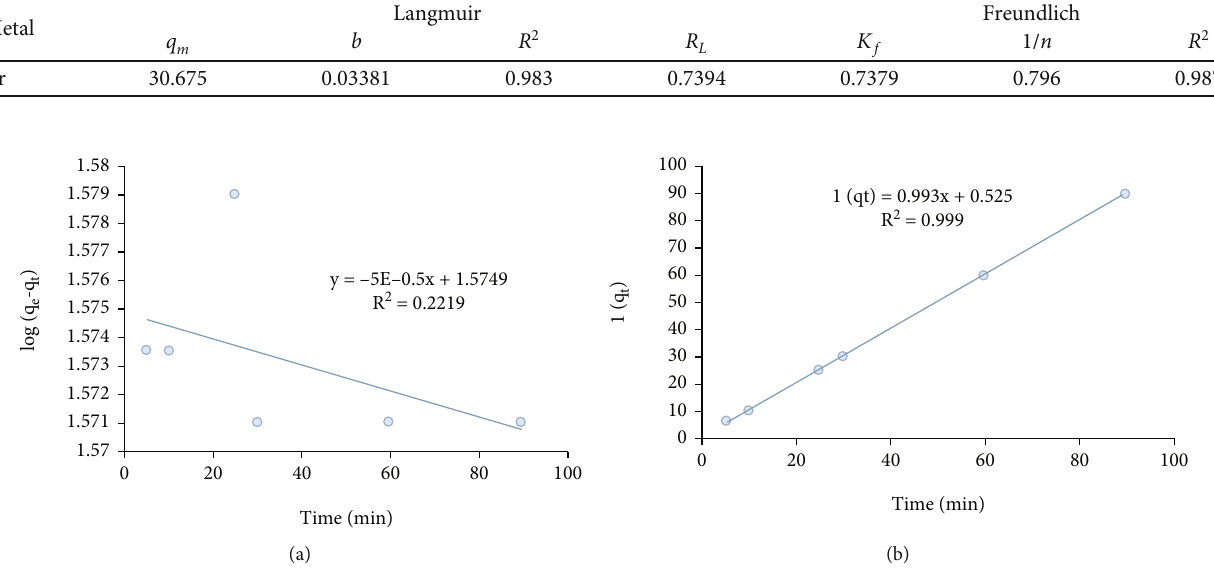
Figure 10: Adsorption kinetics plot of Cr at (a) pseudo fi rst order and (b) pseudosecond order.